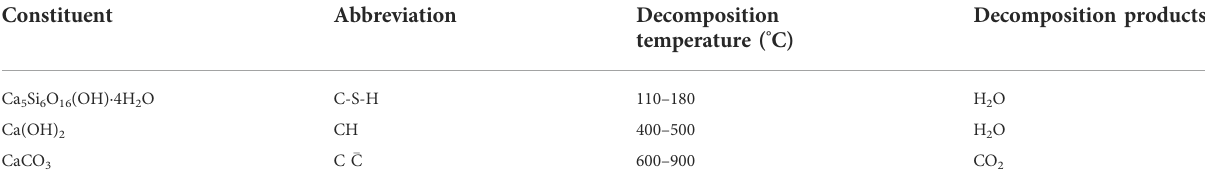
TABLE 2 Decomposition temperature range and decomposition phases in C 3 S carbonization samples of single-phase